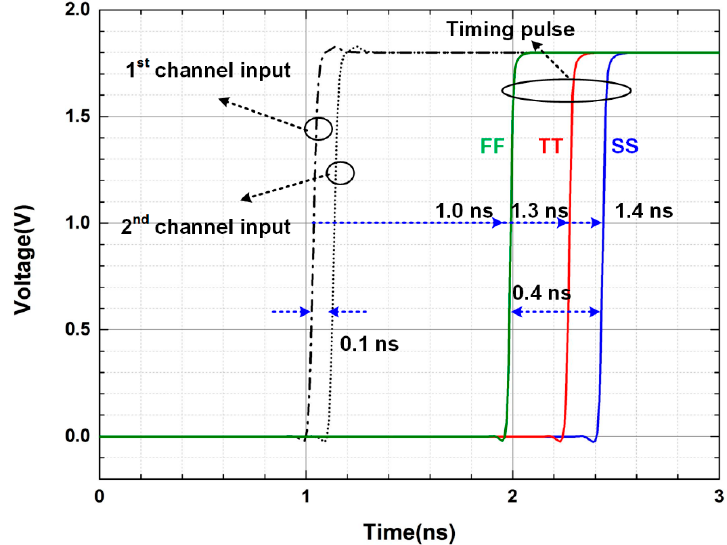
Figure 6. Simulation results of the asynchronous fastest signal identifier (AFSI).